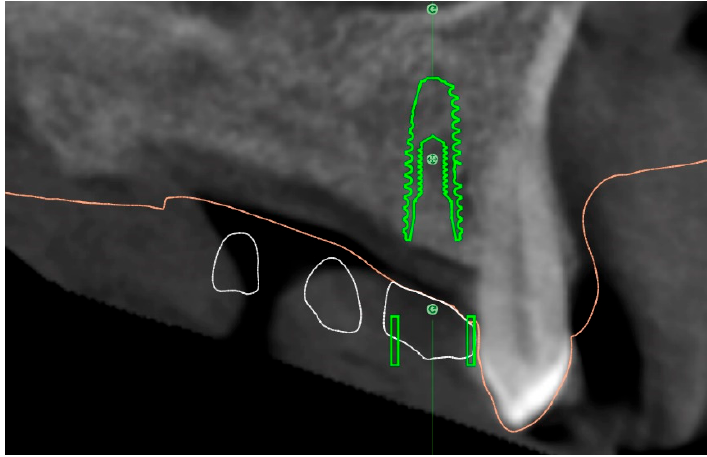
Figure 7. Collision between the mesial side of the metallic sleeve and the patient’s anatomy.